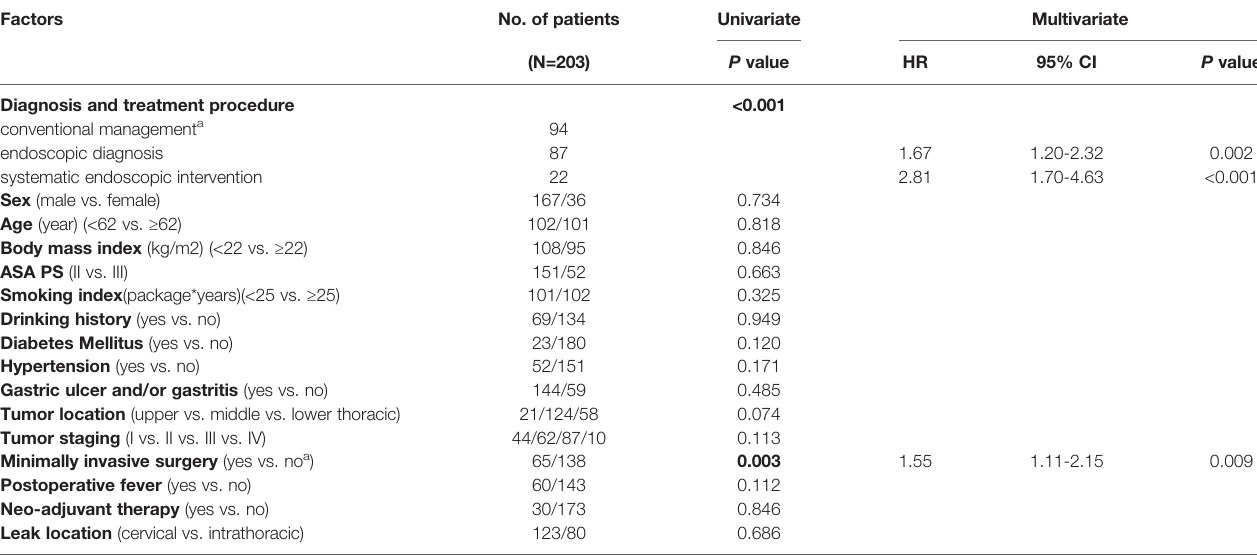
TABLE 1 | Basic characteristics of the 203 patients with EAL and Determinants of EAL postoperative overall healing in patients with EAL. Factors